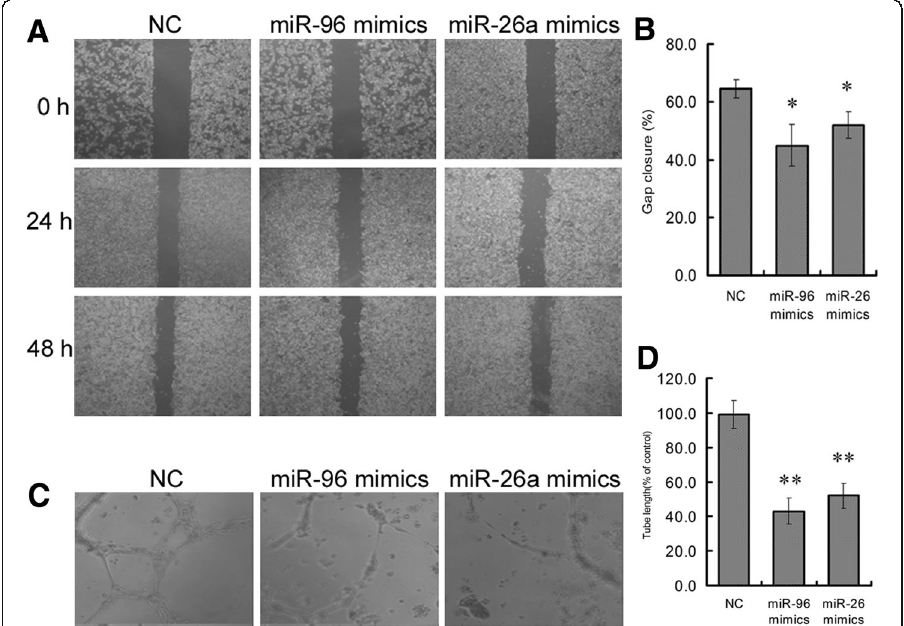
Fig. 3 Overexpression of miR-96 or miR-26a inhibited migration and tube formation. a and b Migration of HUVECs co-incubated for 48 h with platelet-derived microparticles (MPs) after a scratch wound assay. c and d Tube formation was performed after co-incubation with p-MPs. Mimics are small RNA molecules to mimic endogenous mature miR-96 or